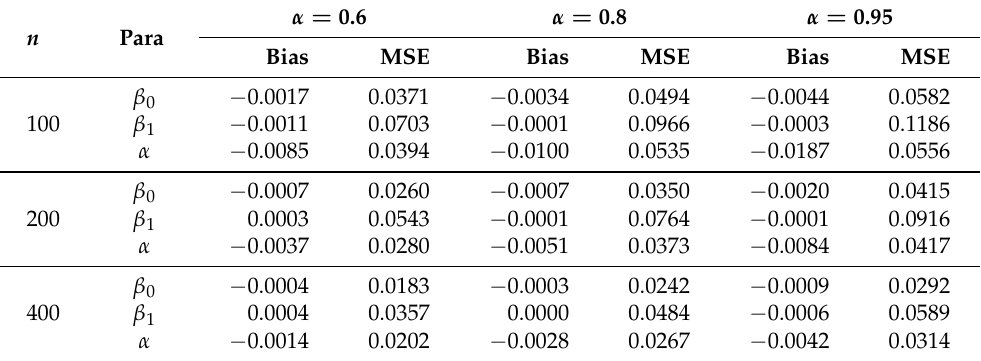
Table 1. Parameter estimates based on 10,000 replications for Case